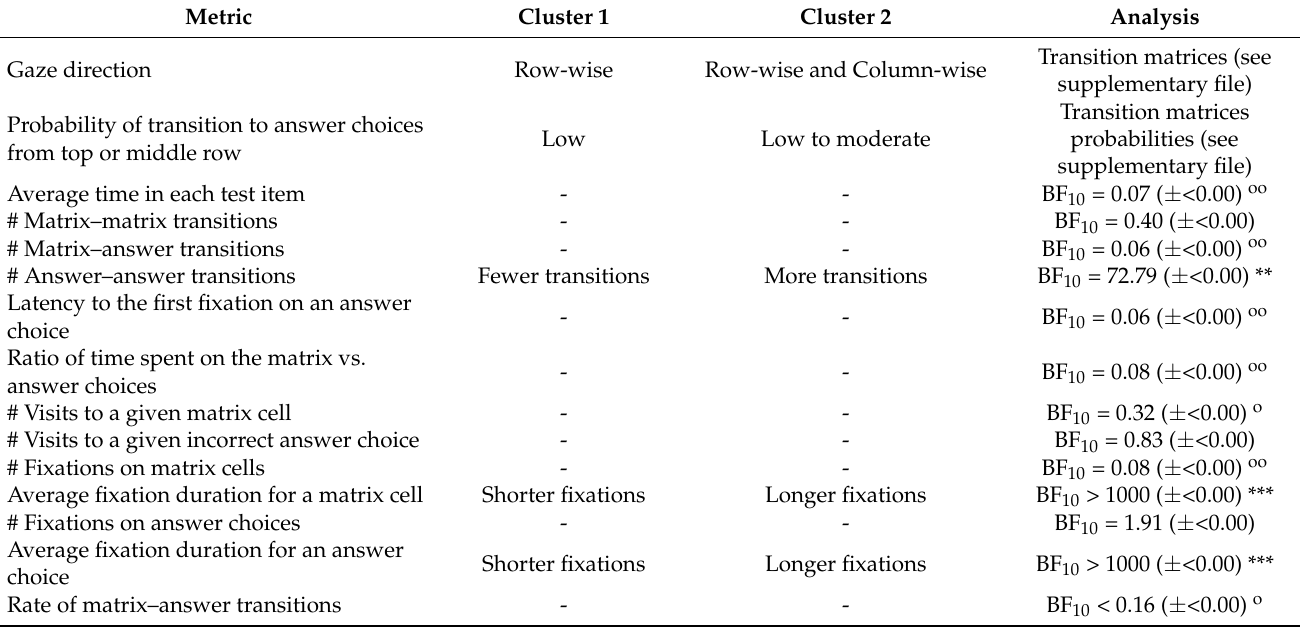
Table 4. Comparison of the model-based clusters of eye movements. The comparison was conducted based on the transition matrices or the Bayes Factor for each cluster. Cluster 1 Cluster 2